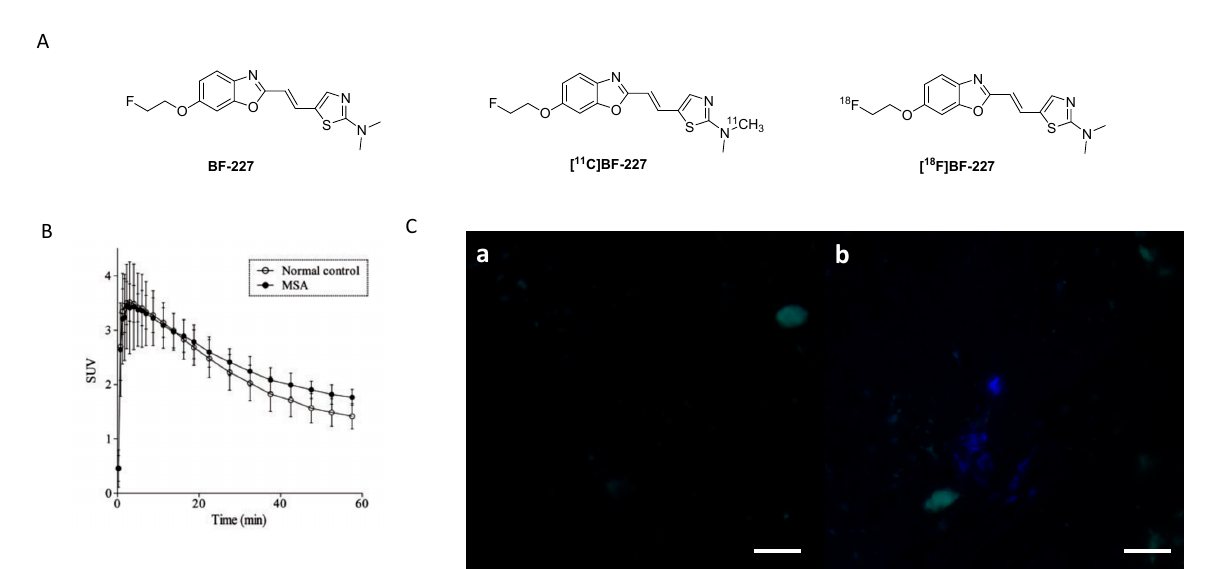
Figure 9. ( A ) Chemical structures of BF-227 , [ 11 C]BF-227 and [ 18 F]BF-227 . ( B ) TACs of [ 11 C]BF-227 in putamen in normal controls and MSA patients (Reprinted with permission from [100]. Copyright 2010 Oxford University Press). ( C ) Fluores- cence detection of BF-227 (at 100 µM) using MSA brain sections. ( a ) Tissue autofluorescence (in green) that is imaged prior to BF-227. ( b ) BF-227 labeling (in blue) of few inclusions. Microscopic examination under DAPI (blue, exposure 500 ms) and FITC (green, exposure 100 ms) filters (adapted from [101]).